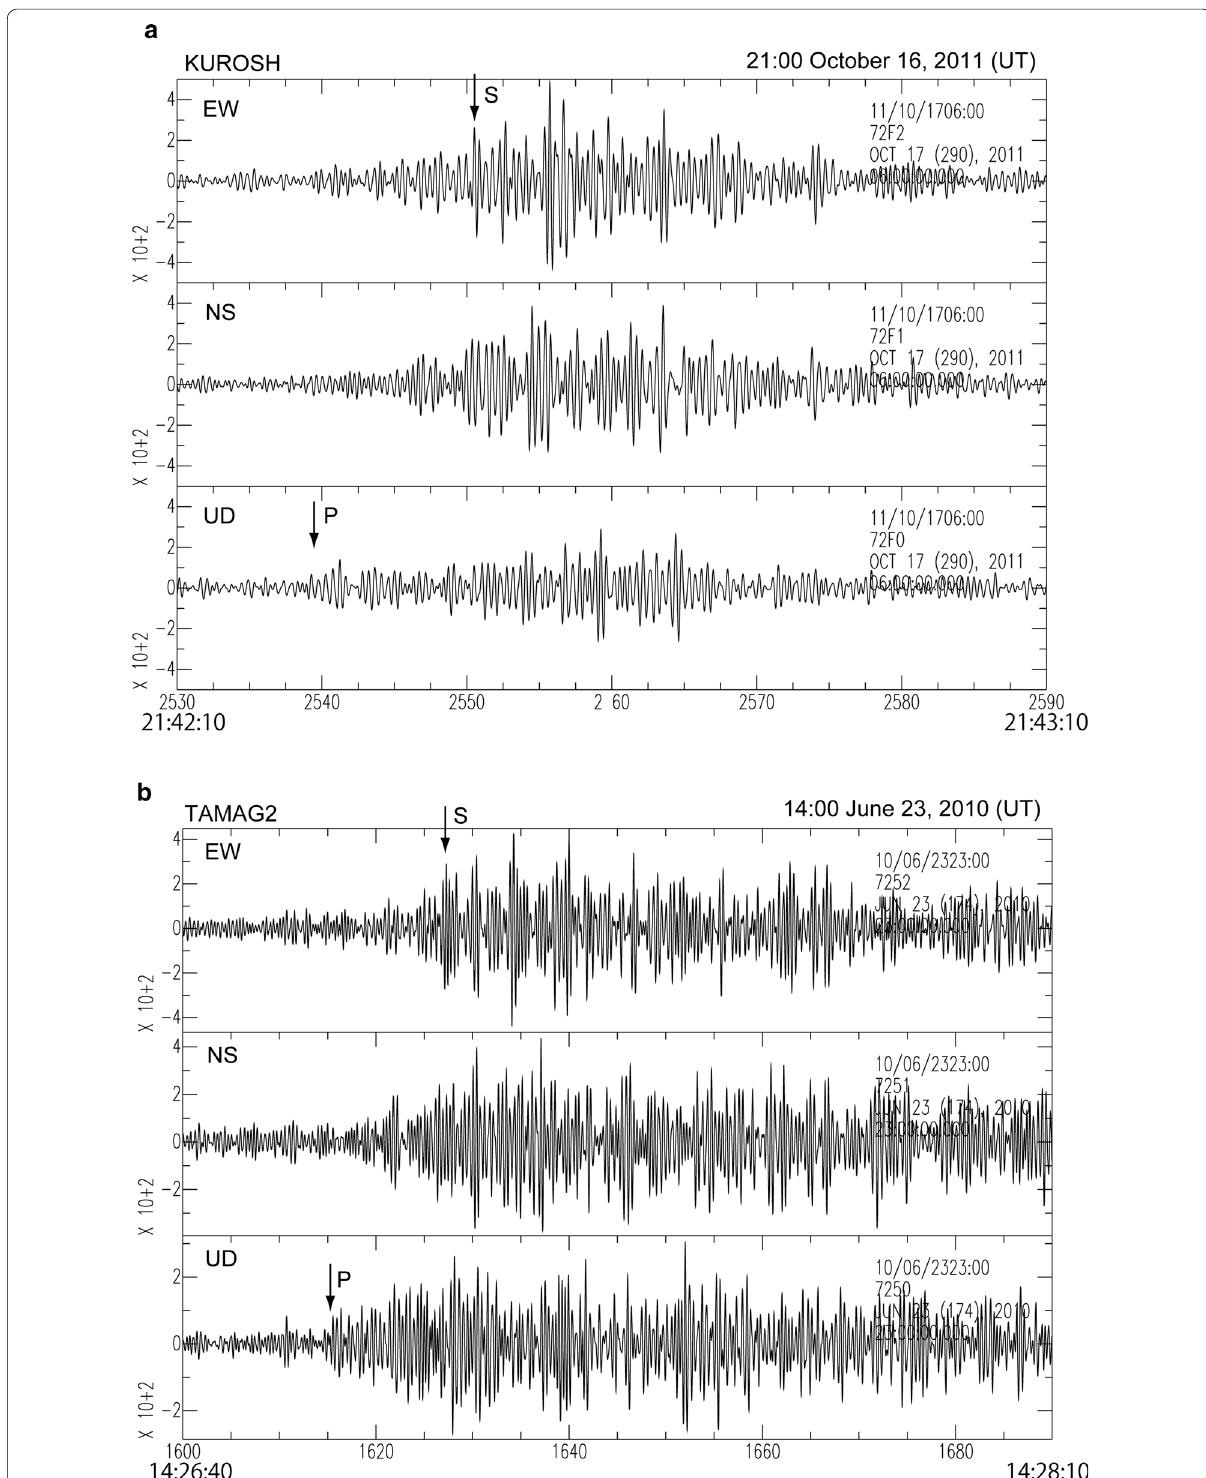
Fig. 5 Three-component seismograms of low-frequency earthquakes (LFEs) from which P and S arrivals were selected. a , b The seismograms at KUROSH and TAMAG2,